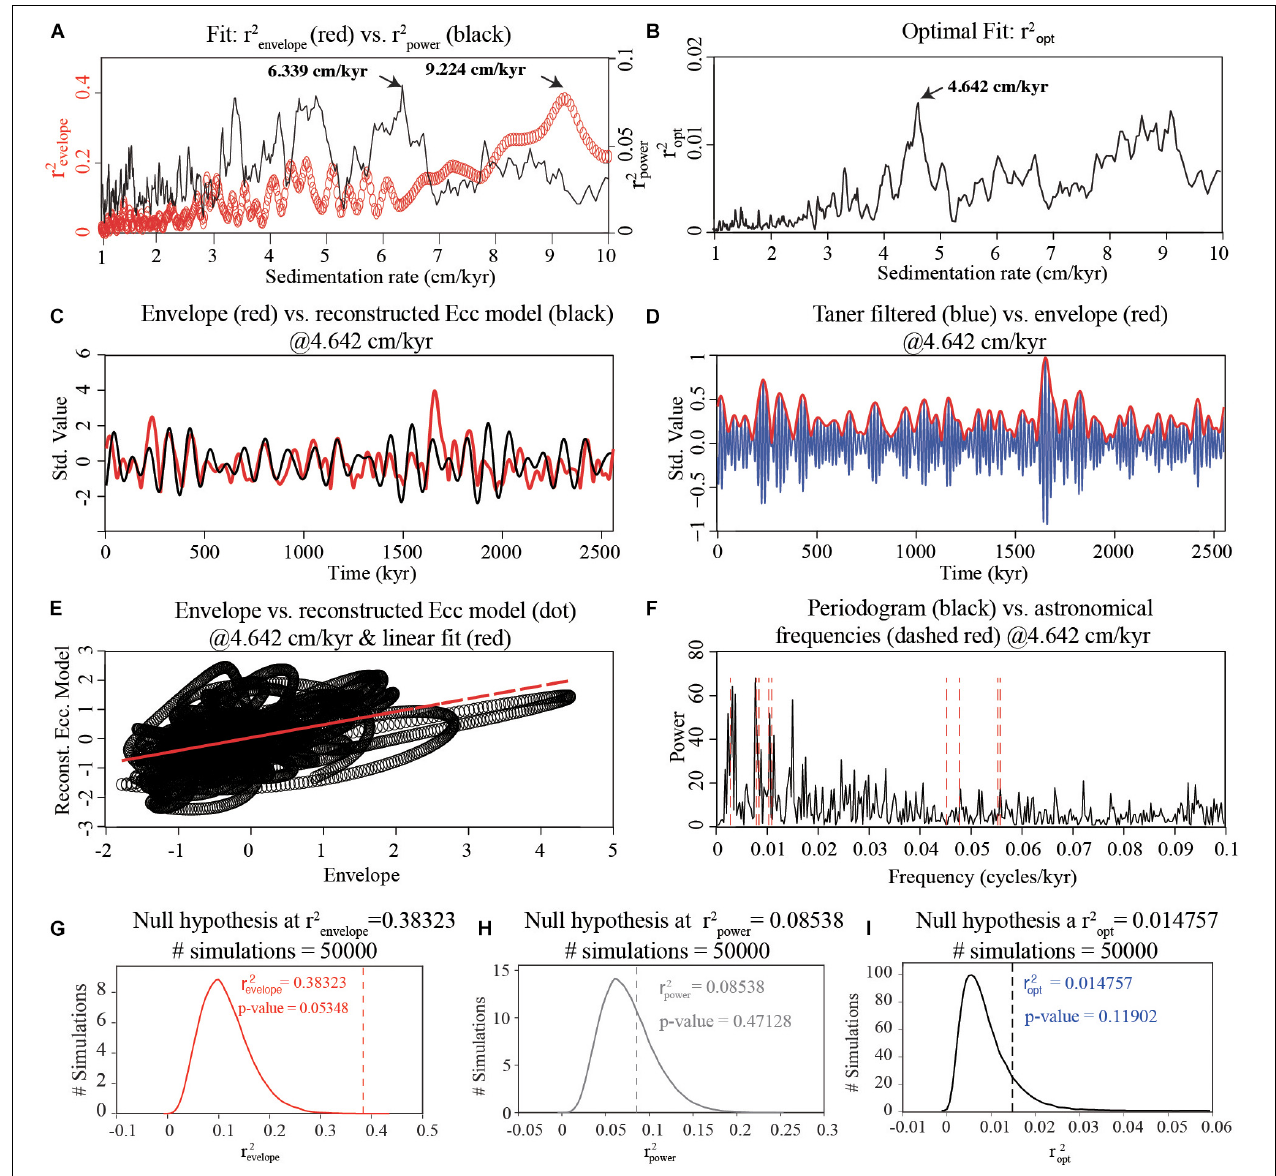
FIGURE 6 | TimeOpt (A–F) analysis and Monte Carlo simulation (G–I) results for the DBG MS series for 400 test sedimentation rates from 1 to 10 cm/kyr. The Taner filter passband was set to f low = 0.045 cycles/kyr and f high = 0.069 cycles/kyr; the roll-off was set to 10 12 . The input orbital eccentricity model frequencies and precession index frequencies are from the La2004 solution ( Table 1 ). (A) Pearson correlation coefficient vs. test sedimentation rate for the amplitude envelope of the precession index band (r 2 envelope ) and eccentricity model (r 2 power ). (B) The combined Pearson correlation coefficient r 2 opt = r 2 envelope · r 2 power indicating an optimal sedimentation rate of 4.642 cm/kyr. (C) . Comparison of the precession band amplitude envelope (red) and eccentricity model (black) for the optimal sedimentation rate of 4.6416 cm/kyr. (D) Taner-filtered precession band and amplitude envelope. (E) Paired amplitude envelope and eccentricity model points illustrating the correlation at the optimal sedimentation rate of 4.642 cm/kyr. (F) . Unsmoothed power spectrum of the MS series evaluated as a time series at the optimal sedimentation rate of 4.642 cm/kyr. (G) 50000 Monte Carlo simulations of AR1 red noise at the sedimentation rate indicated by the amplitude envelope of the precession index band (9.224 cm/kyr; r 2 envelope = 0.38323; p = 0.05348). (H) 50000 Monte Carlo simulations of AR1 red noise at the sedimentation rate indicated by the orbital eccentricity model (6.339 cm/kyr; r 2 power = 0.08538; p = 0.47128). (I) 50000 Monte Carlo simulations of AR1 red noise at the optimal sedimentation rate (4.6416 cm/kyr; r 2 opt = 0.014757, p = 0.11902).